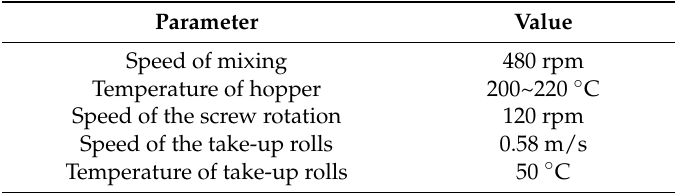
Table 1. The main processing parameters of the mixing and the